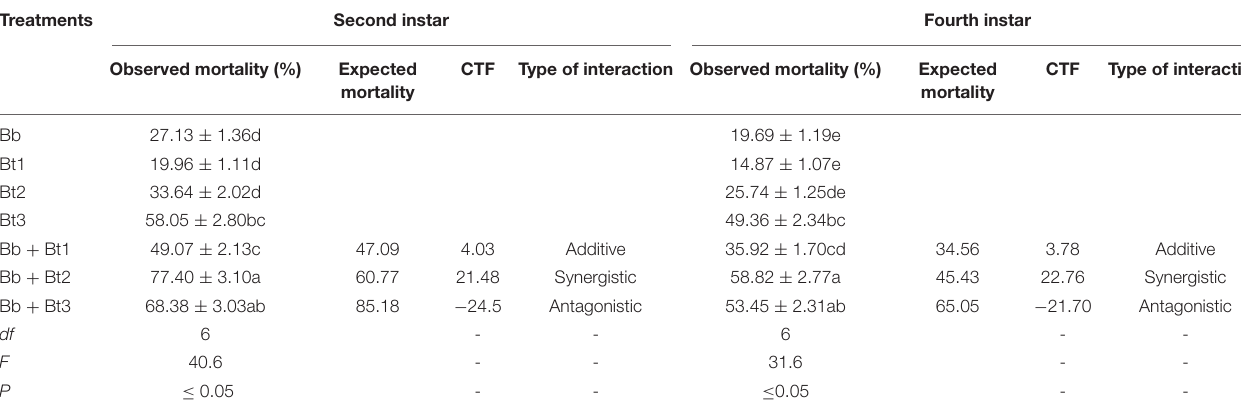
TABLE 2 | Mortality (mean ± SE)% of L2 and L4 instar H. armigera treated with endophytic B. bassiana (Bb: 1 × 10 8 conidia ml − 1 ) alone and in combination with B. thuringiensis (Bt1: 0.50; Bt2: 0.75; Bt3: 1.0 µ g ml − 1 ). Treatments Second instar Fourth instar Observed mortality (%) Expected CTF Type of interaction Observed mortality mortality